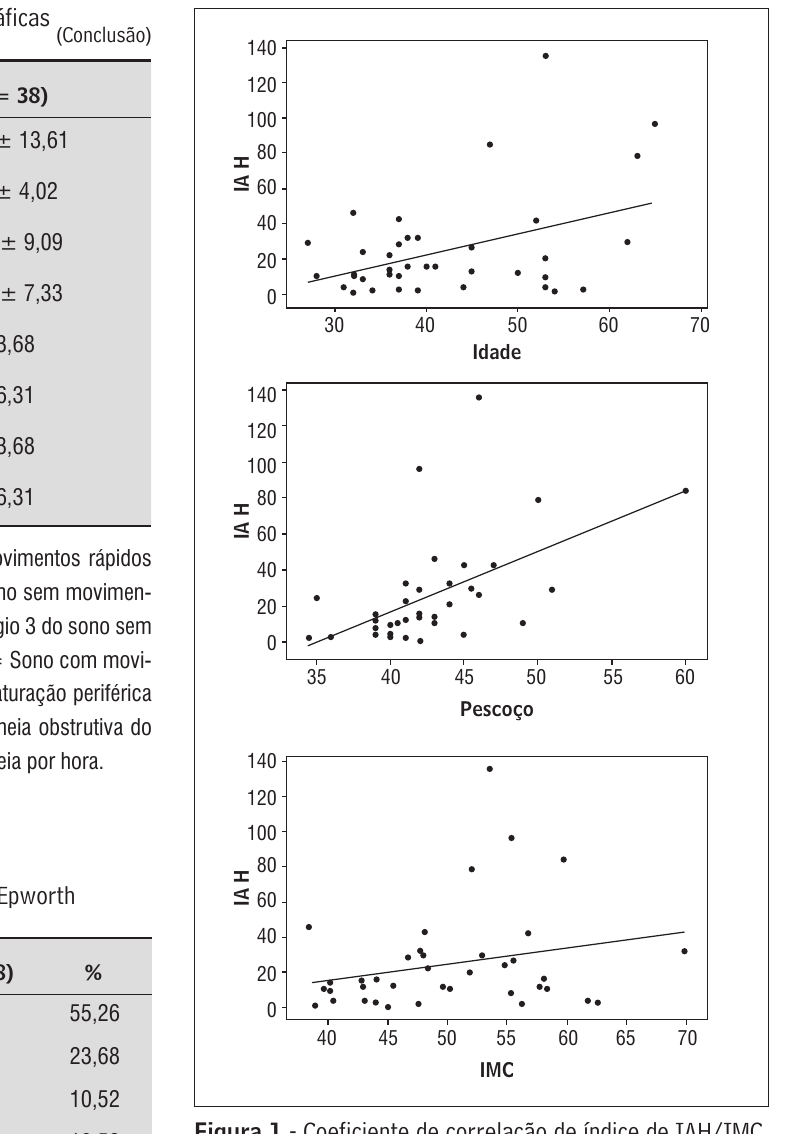
Figura 1 - Coeficiente de correlação de índice de IAH/IMC, IAH/idade e IAH/circunferência do pescoço Fonte: Dados da